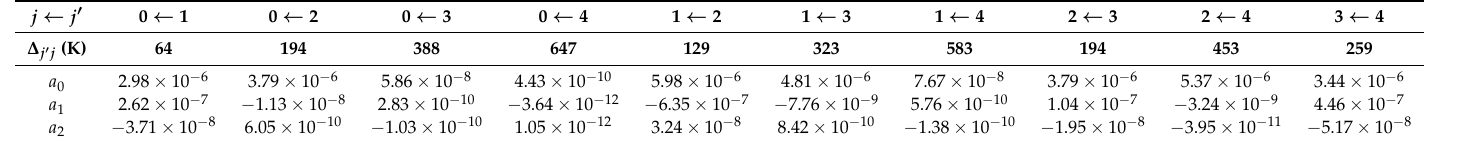
Table 10. Same as Table 7 for 3 HeD +